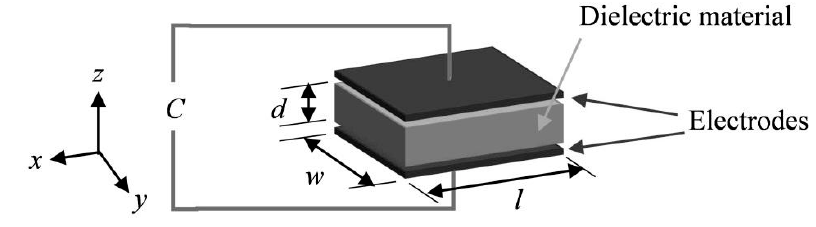
Figure 2. Parallel plate capacitor model of the pressure sensor.